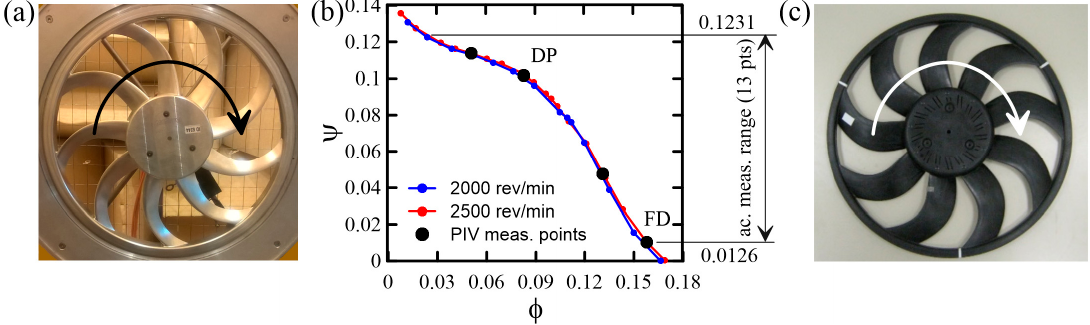
Figure 1. The low-speed fan. ( a ) Investigated rotor; ( b ) non-dimensionalized characteristic curves of the investigated rotor; ( c ) previously studied rotor.